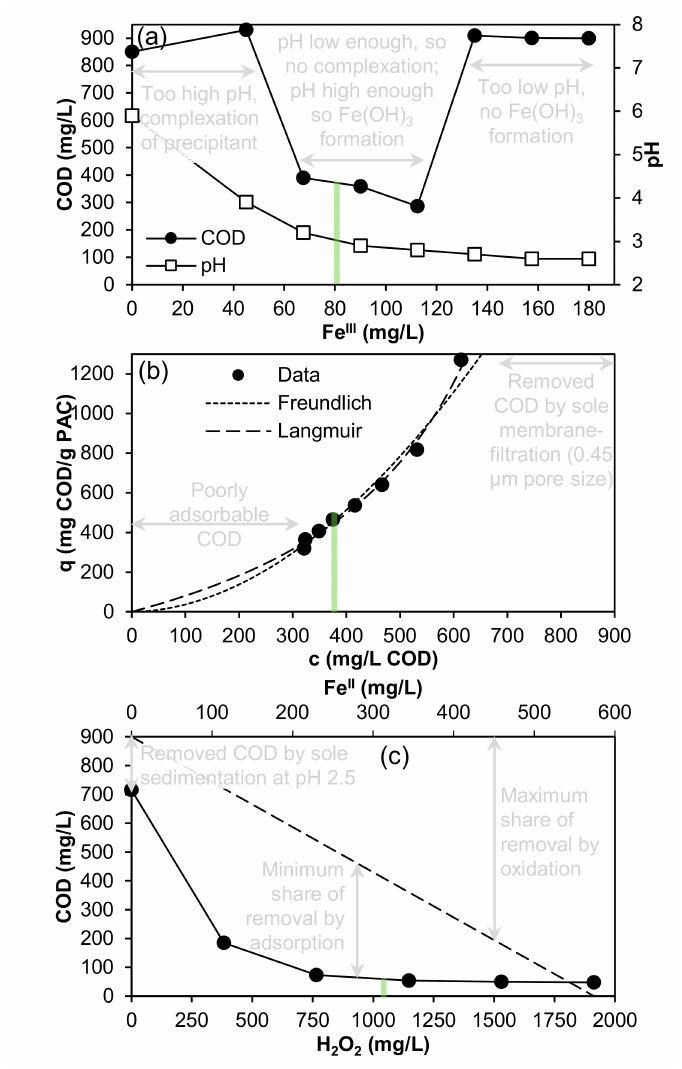
Figure 3. COD removal in the course of the treatment of raw wastewater sample A (pH 6, 0.9 g/L COD) with three different methods as a function of the reagents on a scale of 50 mL. Vertical green markings represent the dosages used for the experiment shown in Figure 4. ( a ) Treatment with FeCl 3 for 10 min. The COD was measured in the supernatant after neutralization. The stated pH value corresponds to that in the supernatant before neutralization, but differed from the one directly after the addition of Fe III only marginally. ( b ) Treatment with PAC for 30 min. The COD was measured in the filtrate after membrane filtration (0.45 µ m pore size). ( c ) Treatment with Fenton reagent at pH 2.3–2.5 for 60 min. The COD was determined in the supernatant after